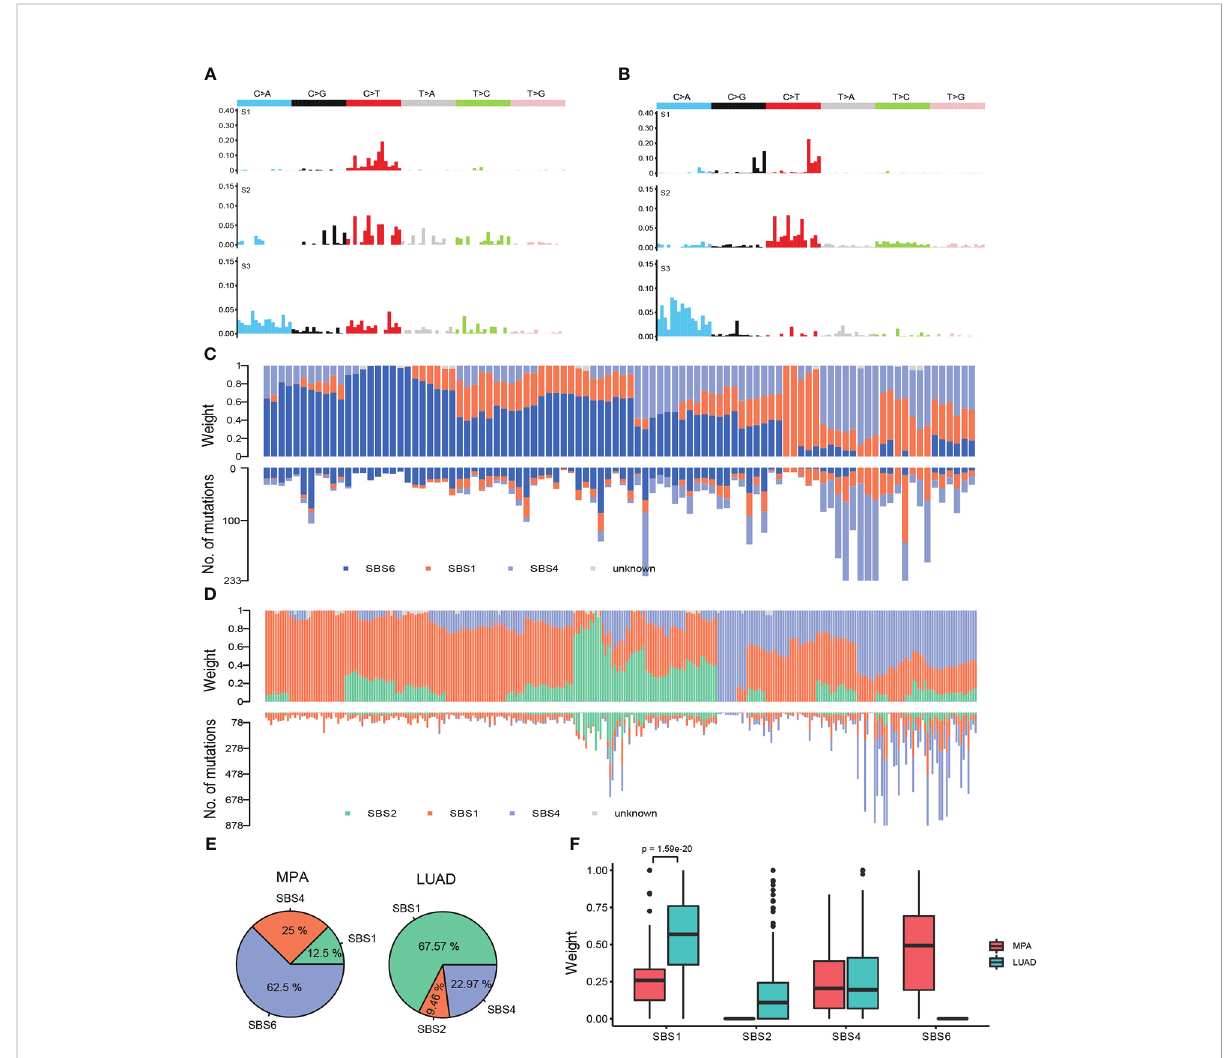
FIGURE 4 Mutational signatures of MPA and LUAD cohort. (A) , Single nucleotide variation analysis of the three signatures predicted in MPA. (B) , Single nucleotide variation analysis of the three signatures predicted in LUAD. (C) , The number of mutations in each sample of the three signatures predicted by MPA (lower part) and the proportion of the three signatures in each sample (upper part). (D) , The number of mutations in each sample of the three signatures predicted by LUAD (lower part) and the proportion of the three signatures in each sample (upper part). (E) , Proportion of samples for each signature in MPA and LUAD. (F) , The weight means of each signature in each sample. The P -value was obtained by the Wilcox